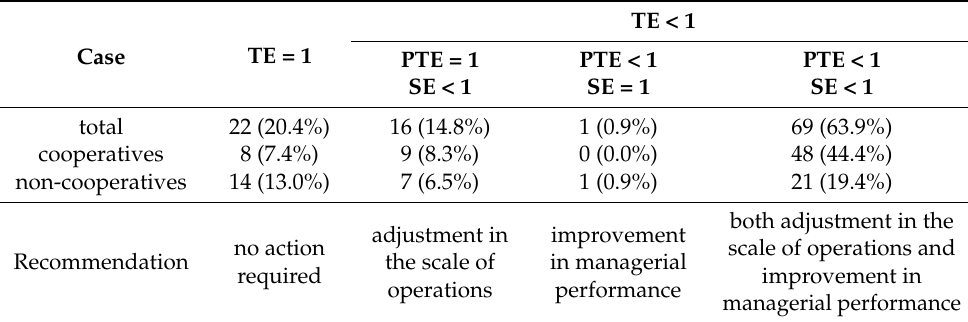
Table 10. Classification of dairies according to TE, PTE, and SE scores (authors’ elaboration).